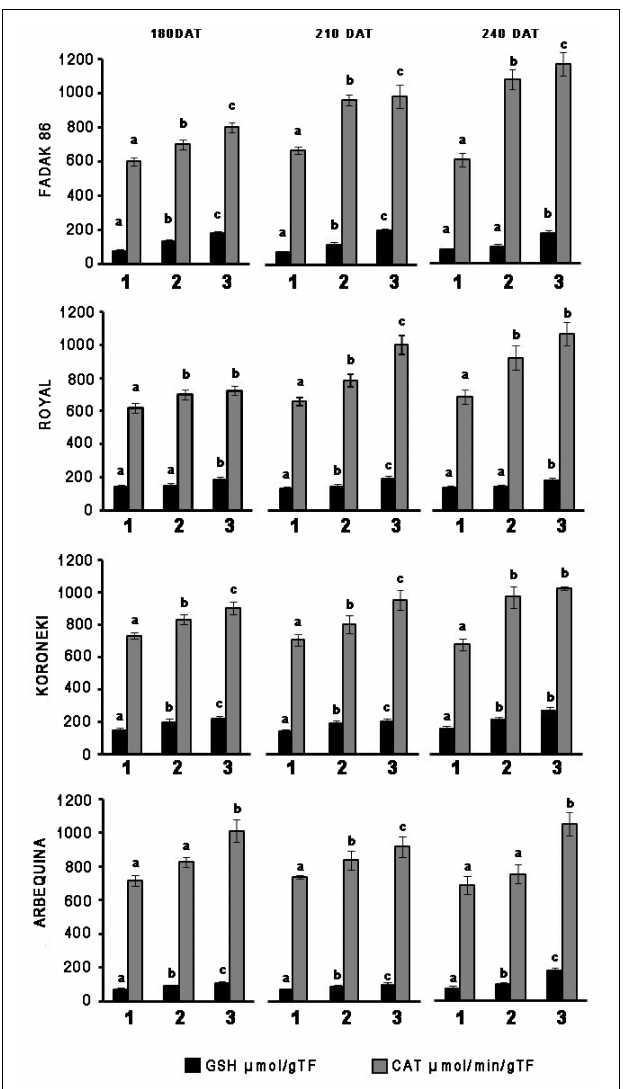
FIGURE 1 | Time-points of glutathione reductase (GSH) and catalase (CAT) activity in leaves of four olive cultivars under saline stress. (1) control, (2) 100 mM NaCl, and (3) 200 mM NaCl. Each value represents the average of five experiments ± SEM. Mean values followed by different letters are significantly different ( P < 0.05).